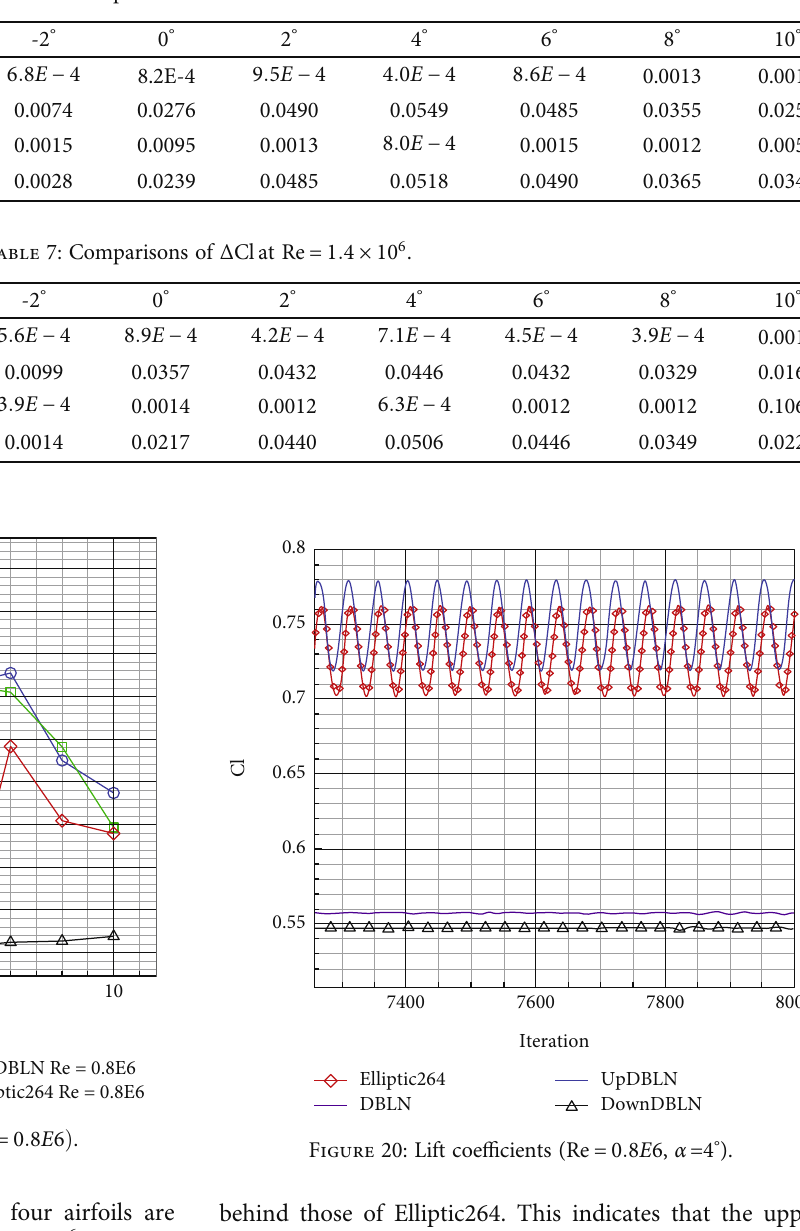
Table 6: Comparisons of Δ Cl at Re = 1 : 2 × 10 6 .